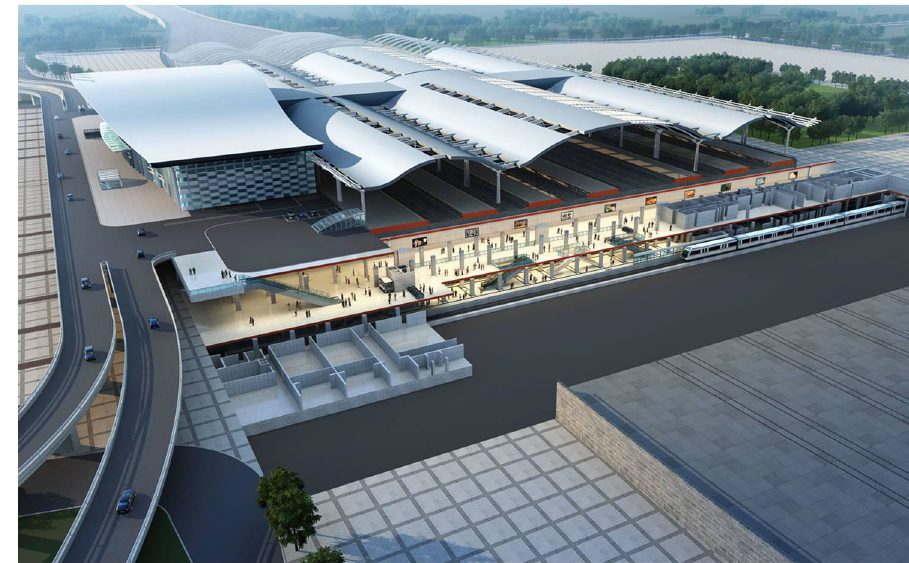
Fig. 8 High-speed railway station design sketch of Xuzhou Metro line